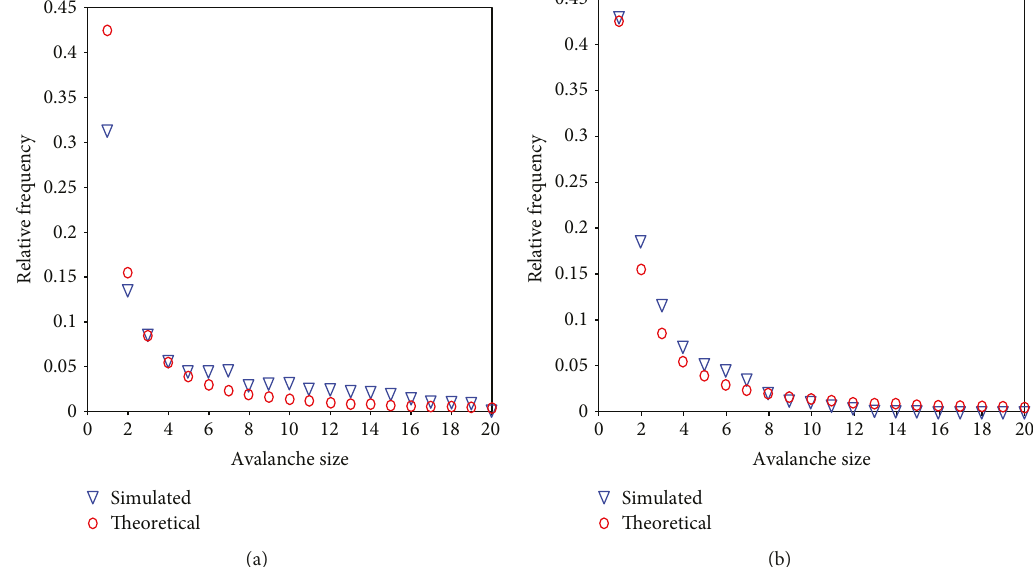
Figure 2: Distribution of all avalanches (a) and noninterfering avalanches (b) observed in simulations from RBNs with 20 nodes, 2 inputs per node, and only canalizing functions